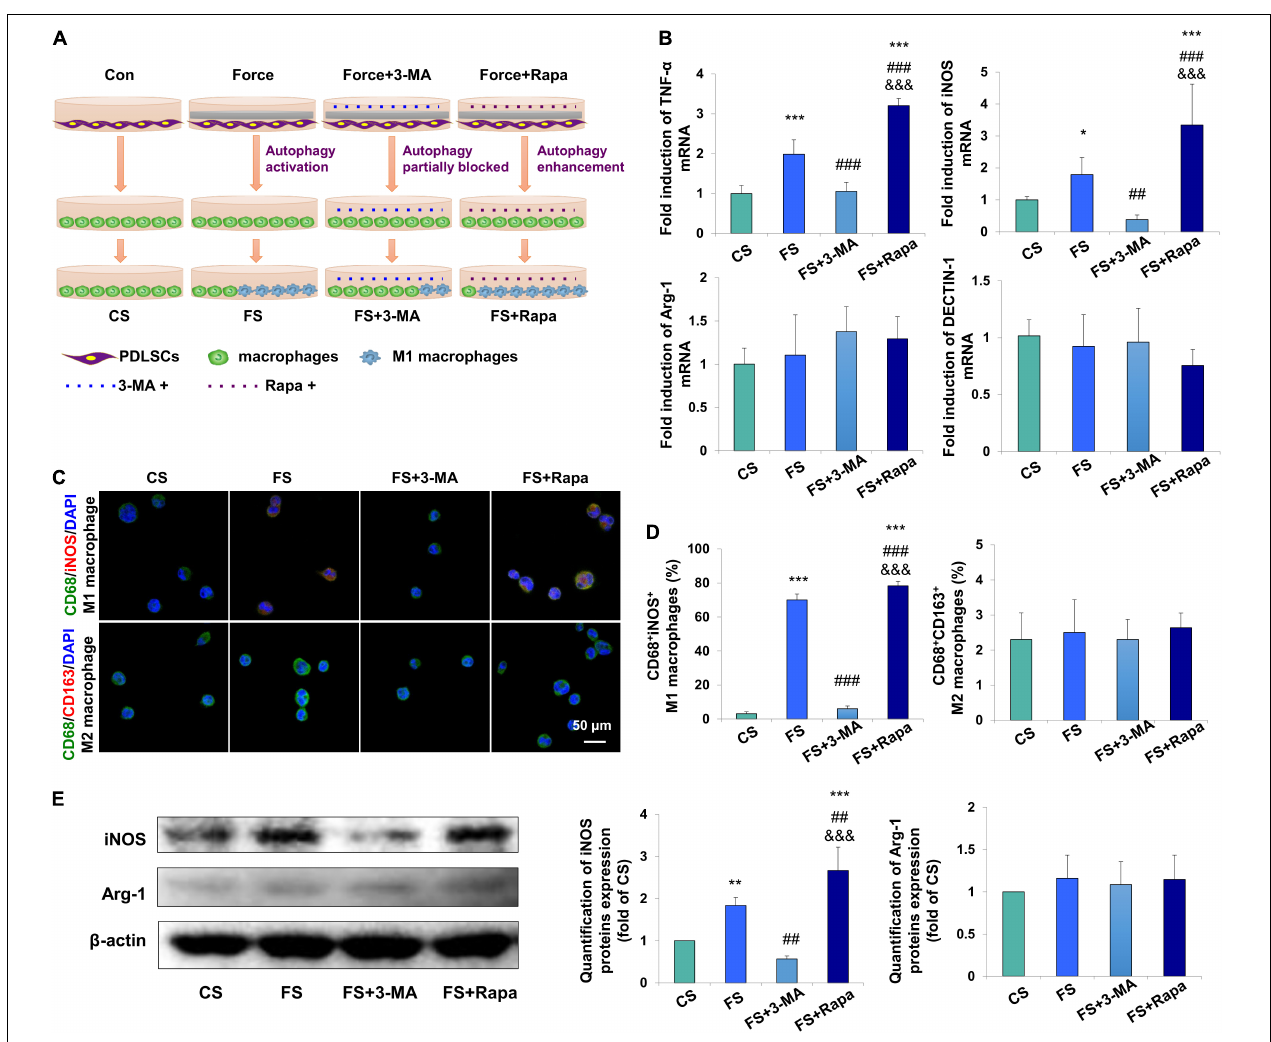
FIGURE 3 | Force-stimulated PDLSC autophagy induces M1 macrophage polarization in vitro . (A) Schematic illustration. (B) Relative mRNA expression of M1/M2-related genes of THP-1-derived macrophages with treatment of different conditioned medium. CS: control supernatant; FS: force-loaded supernatant. FS + 3-MA: force-loaded supernatant with 3-MA; FS + Rapa: force-loaded supernatant with rapamycin. Results are presented as mean ± SD. n = 6. ∗ P < 0.05, ∗∗ P < 0.01, ∗∗∗ P < 0.001 versus CS; ## P < 0.01, ### P < 0.001 versus FS; &&& P < 0.001 versus FS + 3-MA. (C) Representative immunocytochemical images of THP-1-derived macrophages. M1 macrophage polarization [CD68 + (green) and iNOS + (red)] increased in the FS group, which decreased significantly after 3-MA application or enhanced after rapamycin application. No change was observed in M2 macrophage polarization [CD68 + (green) and CD163 + (red)]. (D) Quantification of CD68 + /iNOS + double positive cells and CD68 + /CD163 + double positive cells in panel (C) . Results are presented as mean ± SD. n = 3–4. ∗∗∗ P < 0.001 versus CS; ### P < 0.001 versus FS; &&& P < 0.001 versus FS + 3-MA. (E) Western blot of the expressions of iNOS and arginase-1 in THP-1-induced macrophages. Beta-actin served as an internal control for equal loading. Protein expression level was quantified and presented as mean ± SD. n = 3. ∗∗ P < 0.01, ∗∗∗ P < 0.001 versus CS; ## P < 0.01 versus FS; &&& P < 0.001 versus FS + 3-MA.